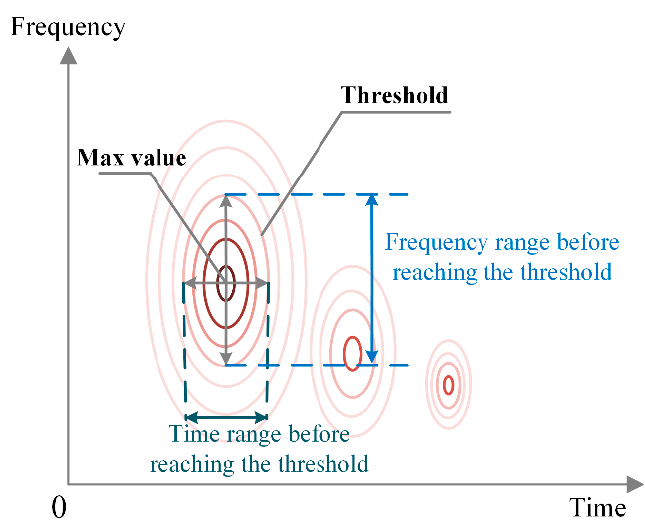
Figure 2. Schematic diagram of the time range and frequency range before reaching the threshold.